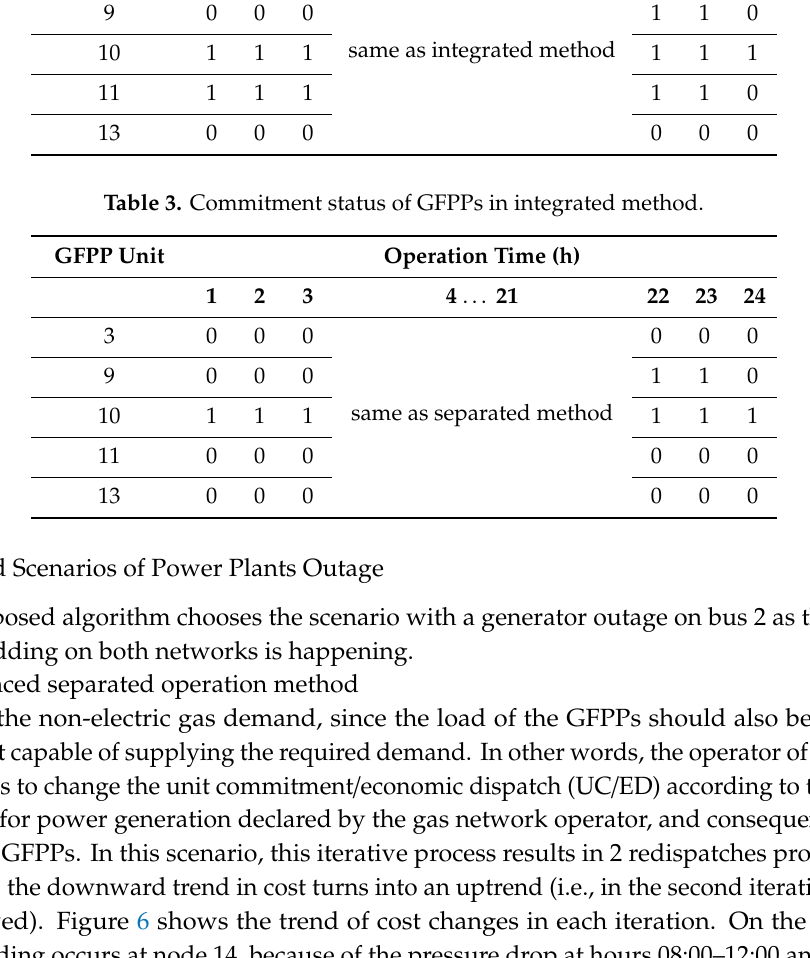
Table 4. Operation Cost of NGEN.